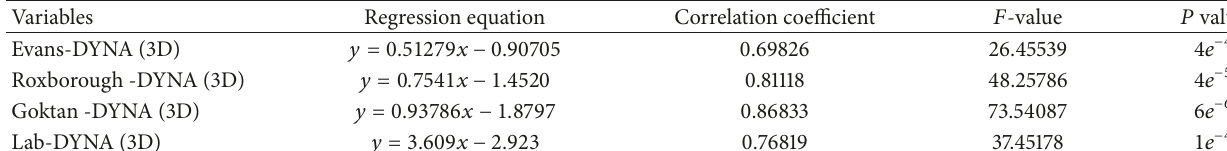
Table 5: Regression results to predict cutter performance.